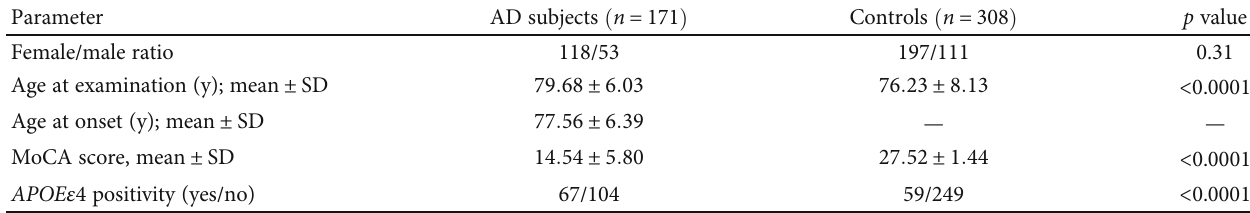
Table 1: Demographic and clinical characteristics of AD patients and controls.